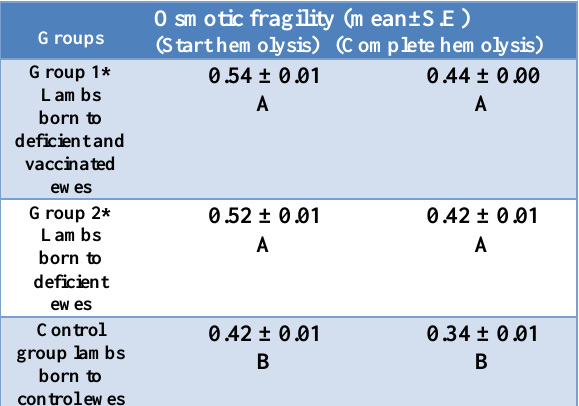
Table, 1: Start and complete erythrocyte osmotic fragility in newborn lambs (control and vit.E and selenium